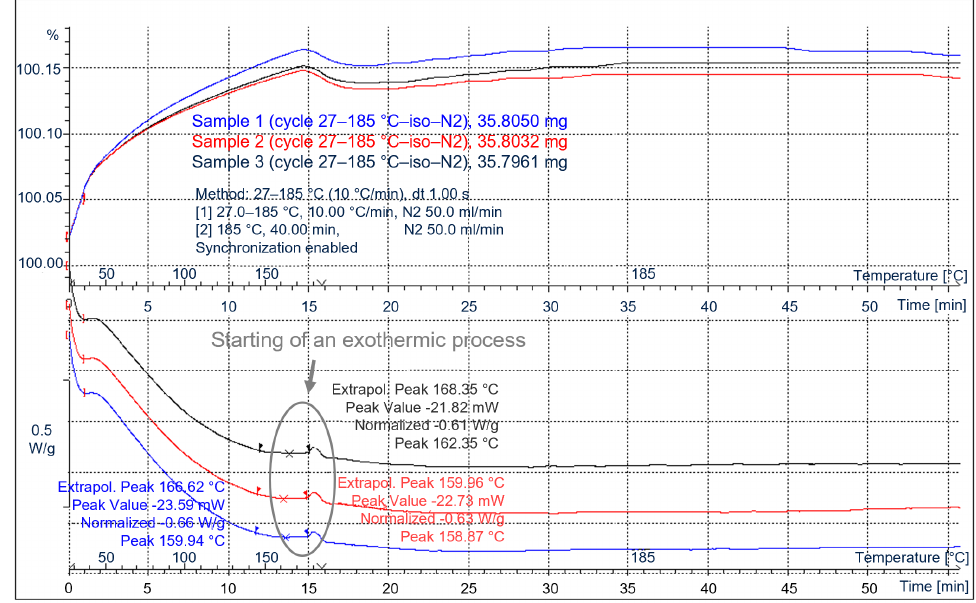
Figure 7. DSC analysis on a thick copper samples which shows the starting of an exothermic process at about